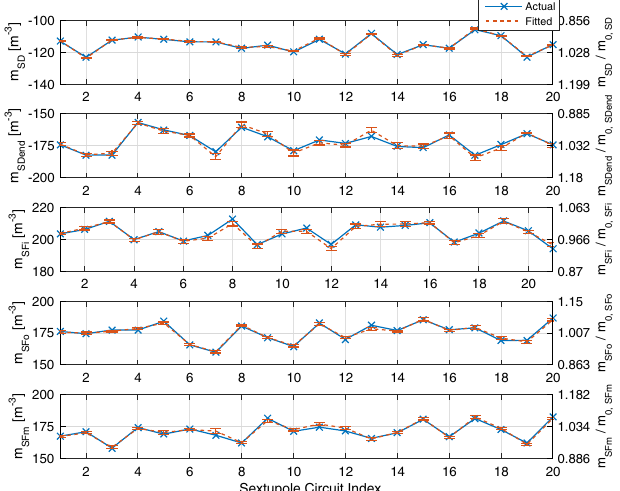
FIG. 5. Introduced and found sextupole circuit errors from one simulation seed. The fitting procedure is able to accurately identify the sextupole settings. The error bars are the standard deviation of 10 error seeds.